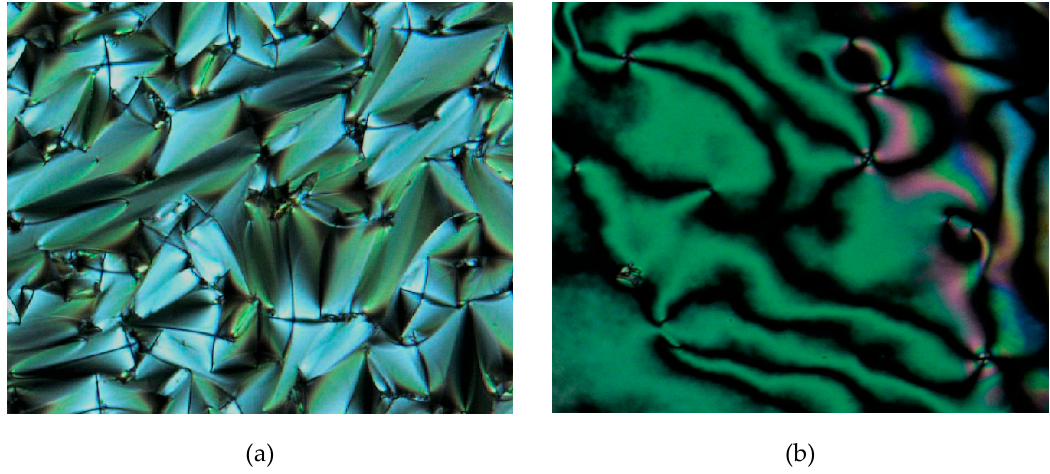
Figure 8. The optical photomicrographs of compound 4a in the cooling cycle: ( a ) focal conic fans of SmA phase at 190.57 °C, and ( b ) thread-like schlieren texture of nematic phase at 223.98 °C (Magnification of 20 × 0.50).